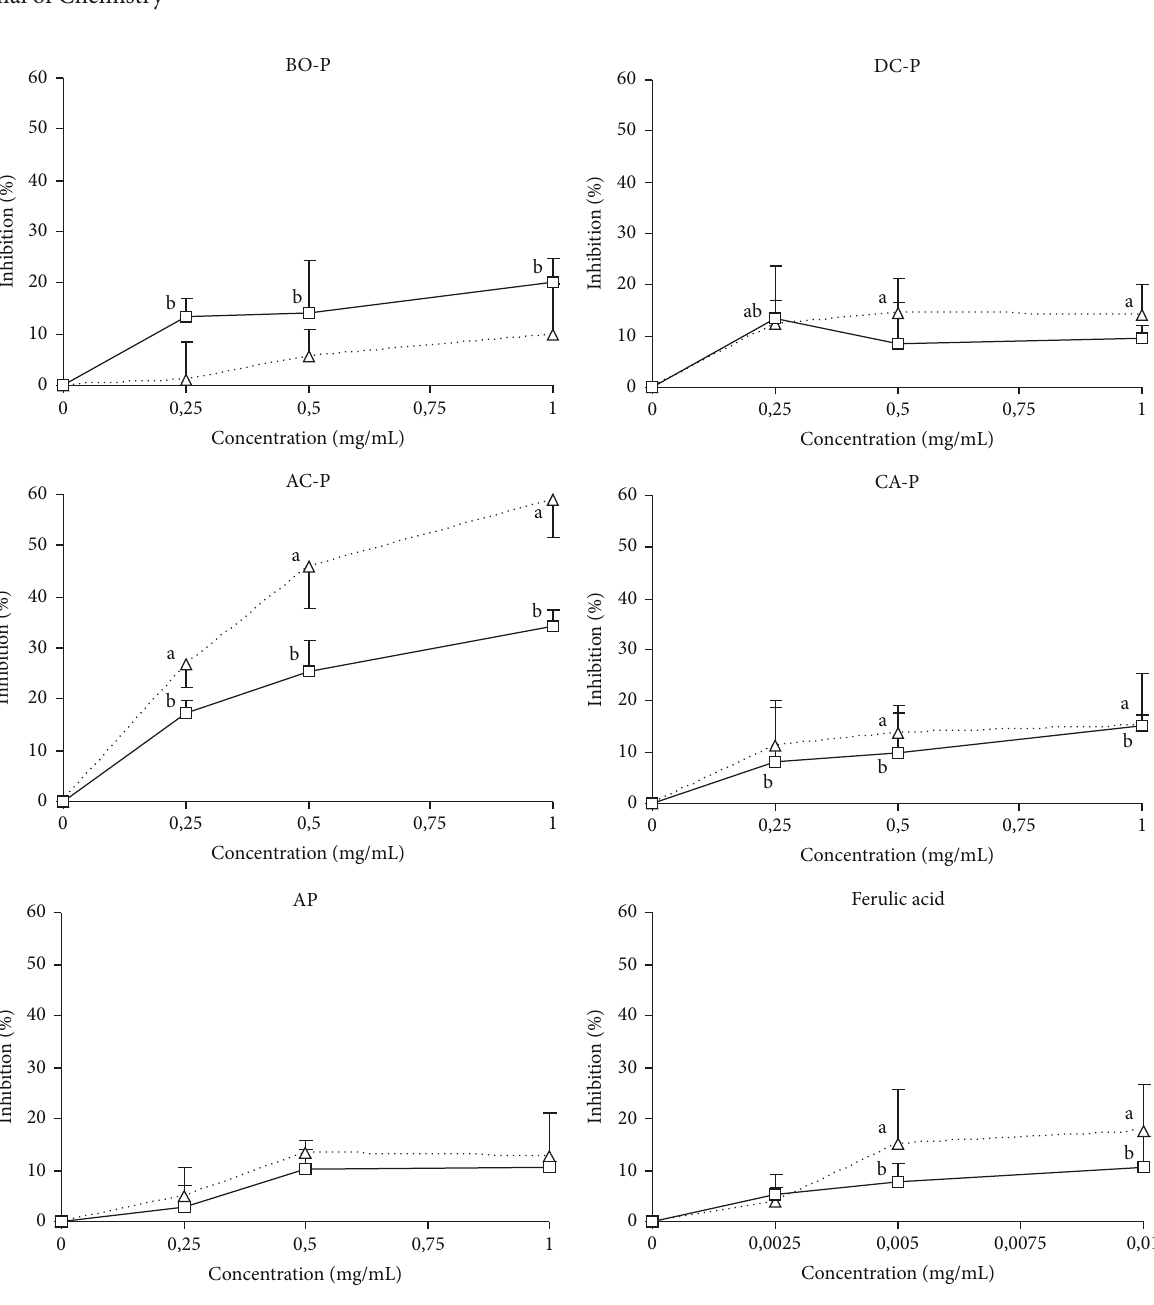
that of BO-P, DC-P, and CA-P (392 versus 297, 206, and 67 mPa s). Therefore, the inhibition of XO activity by pectin fractions is suggested to be partly caused by the increase of the medium viscosity depending on the molecular weight of polysaccharides. Pectin fractions were shown to inhibit XO and scav- enge ROS. Inhibition of XO may be mediated by pec- tic polysaccharide chains, whereas protein and phenolic